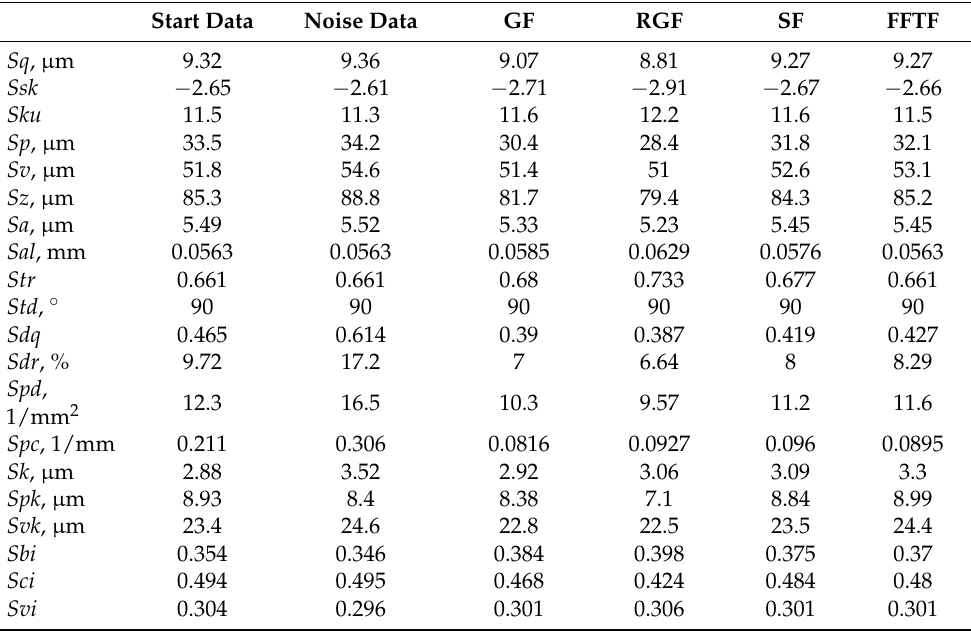
Table 1. Values of surface topography parameters, from the ISO 25178 standard, defined for a primary surface data (start data), containing an HFN (noise data) and after reduction in HFN by various methods: GF, RGF, SF and FFTF, cut-off = 0.025 mm.